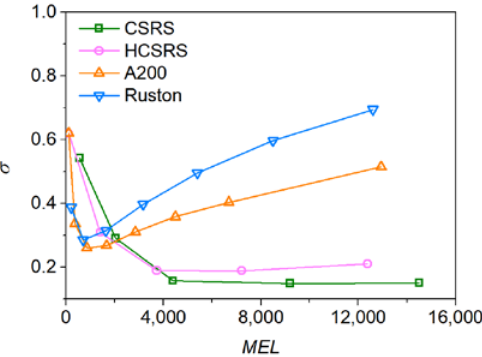
Figure 15. Effect of power consumption per unit volume on the relative standard deviation of particle concentration for the four types of agitators.